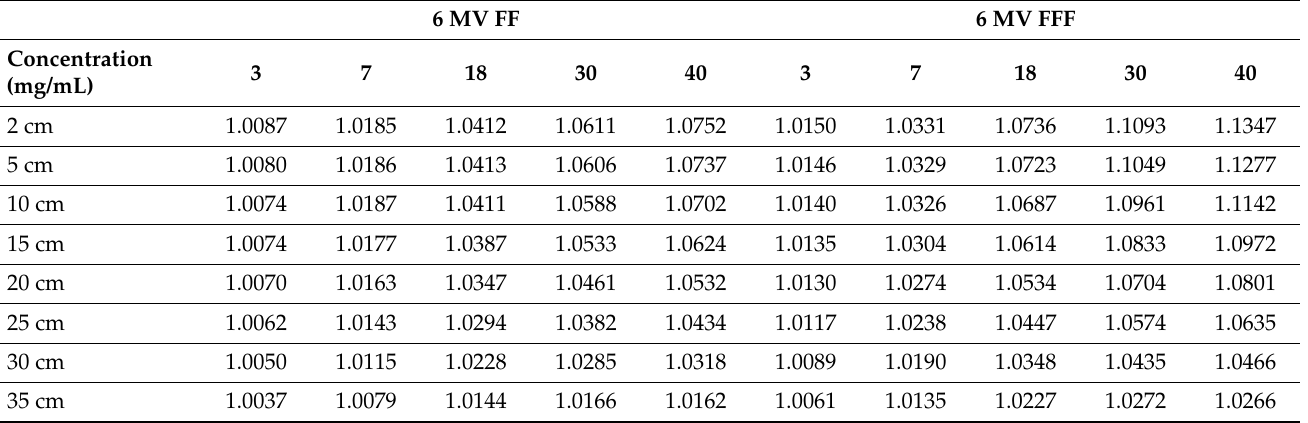
Figure 5. Relationships of flattening filter-free enhancement ratio and phantom depth with variation of NP concentration using the ( a ) 6 MV and ( b ) 10 MV photon beams. Table 1. Dependences of DER on the NP concentration and depth of phantom using the 6 MV FF, 6 MV FFF, 10 MV FF and 10 MV FFF photon beams.